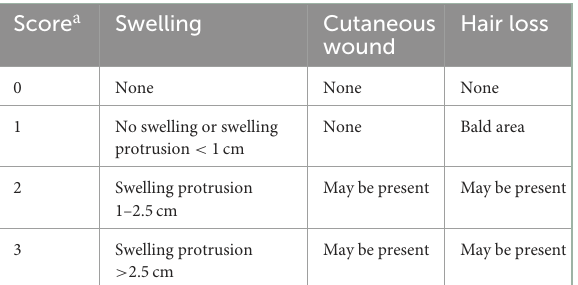
TABLE 1 Hock lesions score